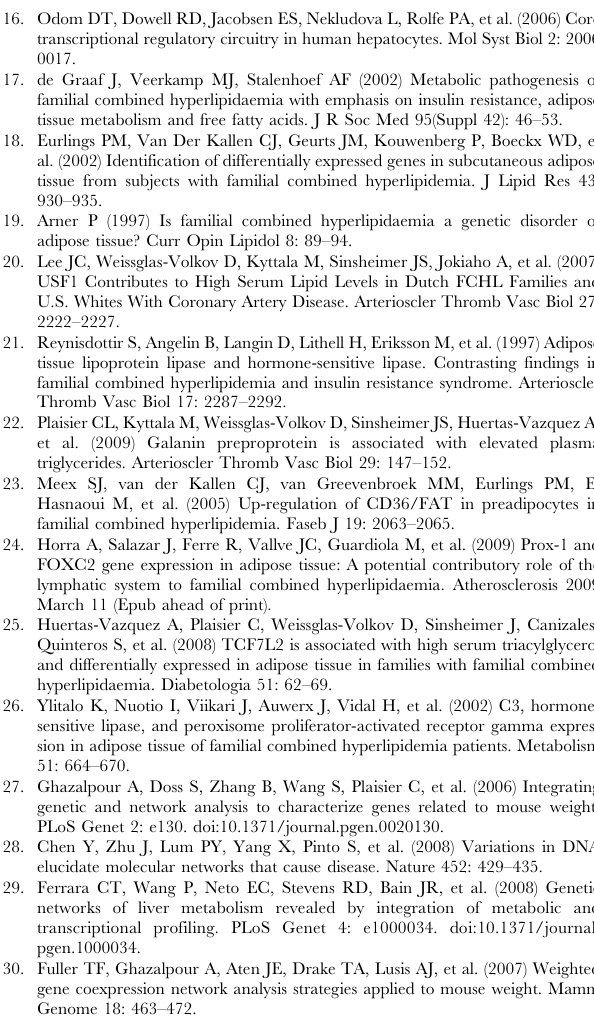
Table S7 Causality testing results for URFA module genes terminating in FCHL, TC, TG, and ApoB. Table S8 Previous association evidence with lipid or atherogenic traits for genes causally linked to FCHL from the URFA module. Table S9 qRT-PCR primers for validation of genes identified as differentially expressed due to USF1 over-expression on micro-